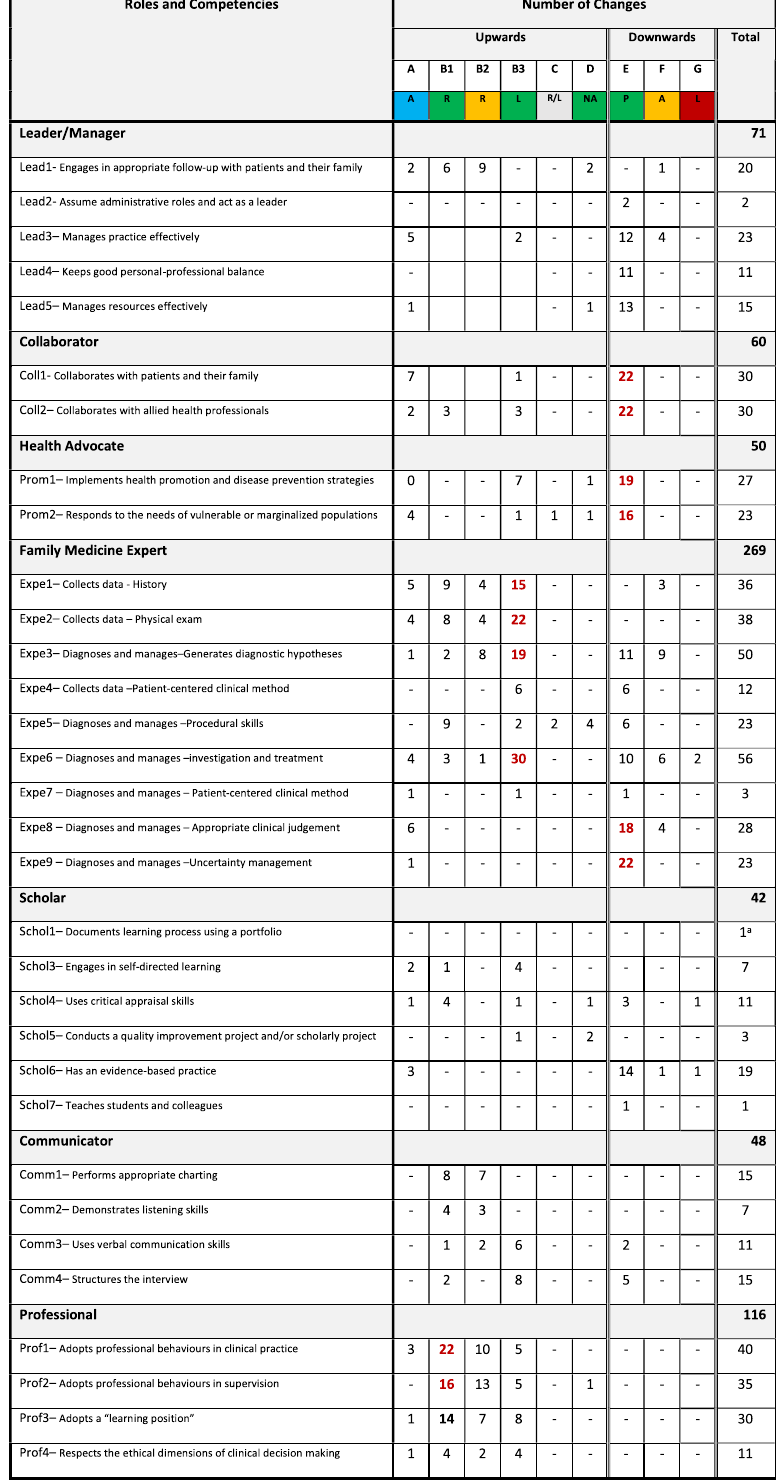
Table 5 Distribution of changes in ratings according to